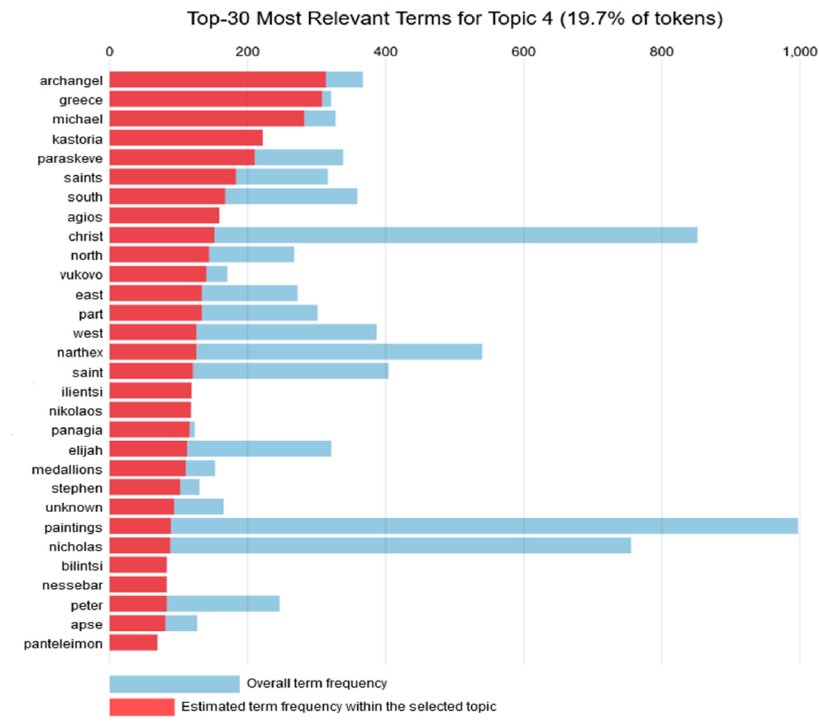
Figure 5. Top-30 most relevant terms for Topic